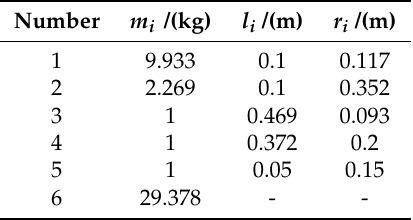
Table 2. Exoskeleton system main